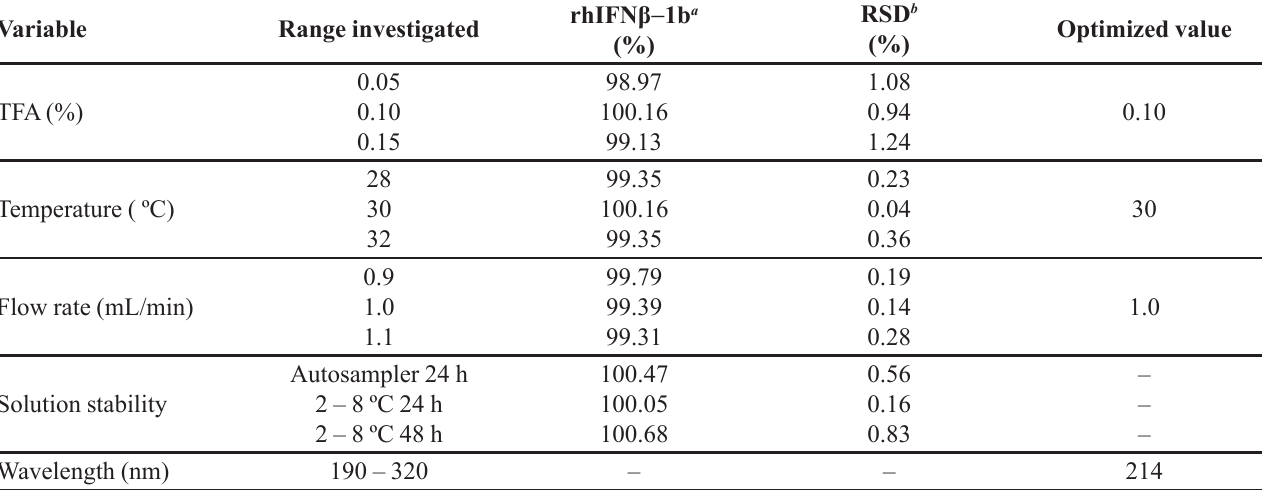
TABLE II - Chromatographic conditions and range investigated during robustness test for the RP-LC method Variable